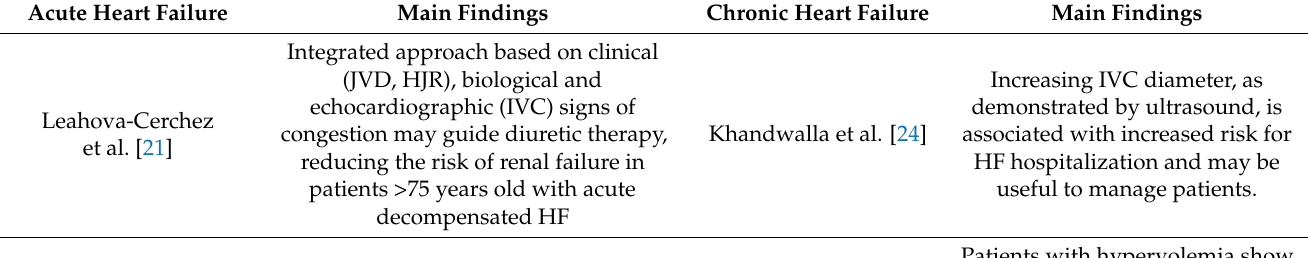
Table 2. Main studies evaluating an approach based on volume status for the management of patients with both acute heart failure and chronic heart